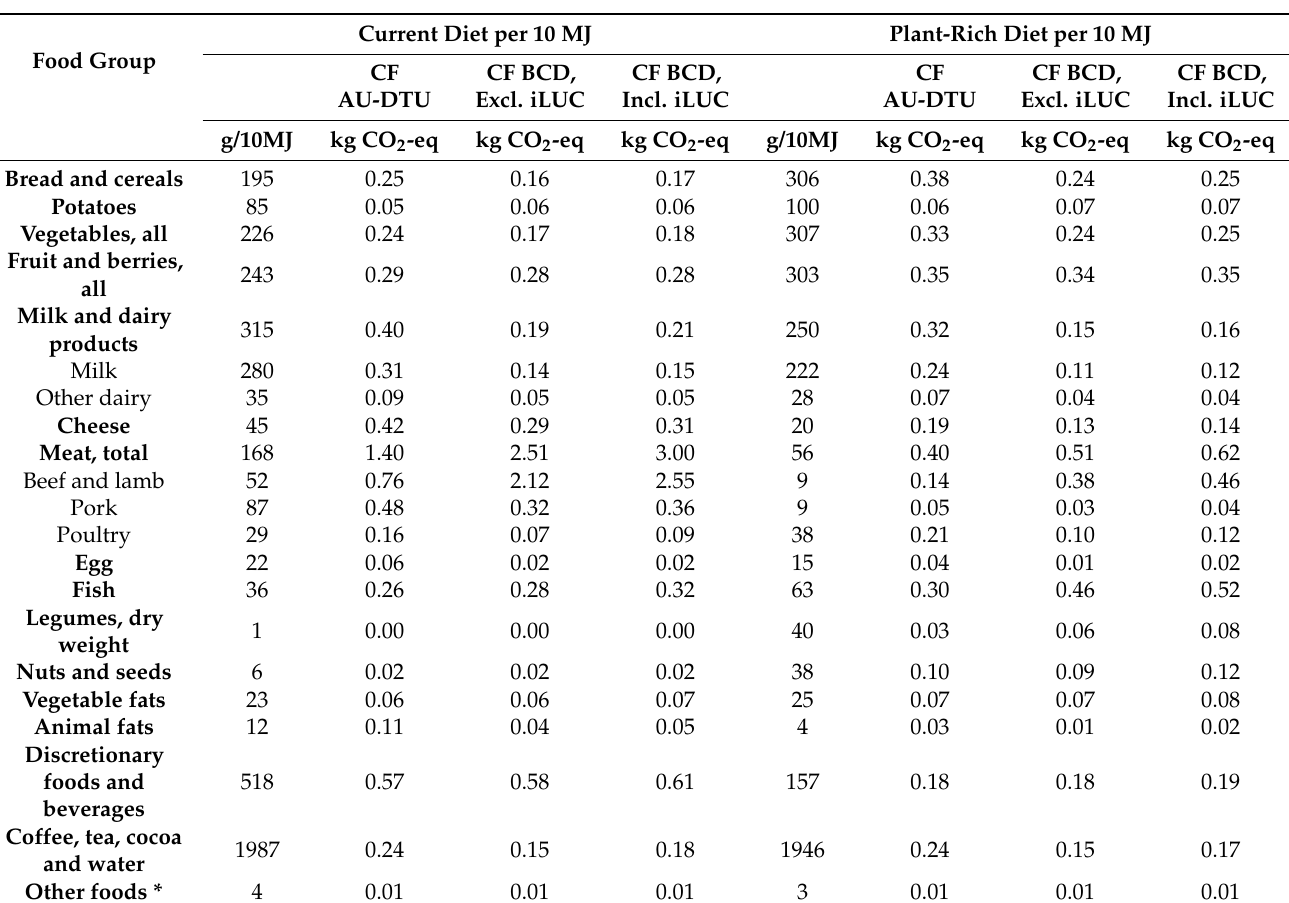
Table 3. Intake g/10 MJ and the carbon footprint (CF) (incl. waste at the retail gate and incl. cooking) of food groups in the current diet and plant-rich diet per 10 MJ based on three CF data sets. The amounts of food are primarily as raw weight, except for prepared foods as bread, sausages, cold cuts and smoked or canned fish